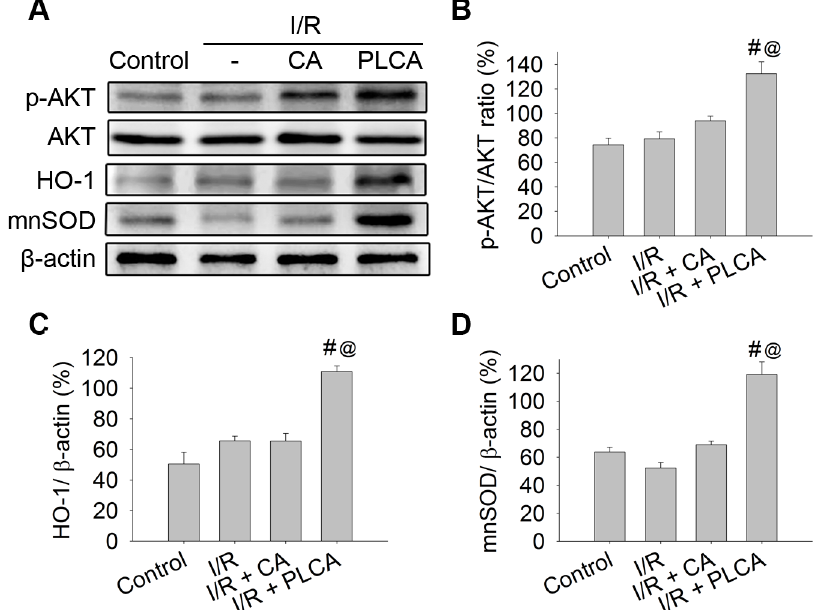
Fig 3. Effect of CA and PLCA on protein expression after rat subjected to myocardial I/R stress. Protein expression was shown in rats subjected to 1 h coronary artery occlusion and followed by 2 h reperfusion. (A) Original western blots were shown. (B) Ratios of p-AKT to AKT, (C) HO-1 to β -actin, (D) mnSOD to β -actin were measured. (n = 4) * P < 0.05 vs. control, # < 0.05 vs. IR, @ < 0.05 vs. IR+CA.